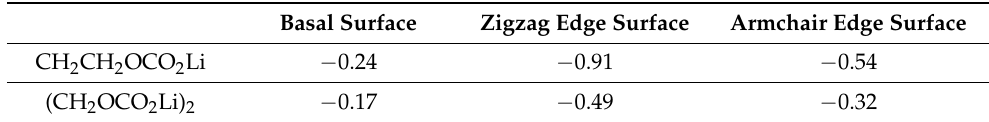
Table 1. The results of the adsorption energies of CH 2 CH 2 OCO 2 Li and (CH 2 OCO 2 Li) 2 on graphite basal, zigzag edge, armchair edge surfaces (units in